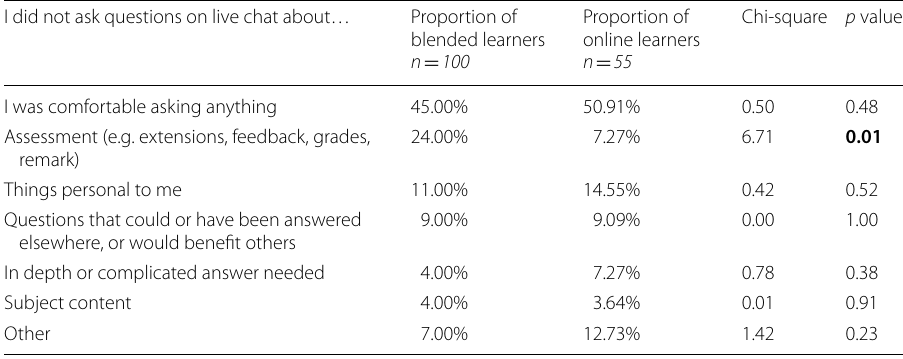
Bold indiactes significant value ( p <